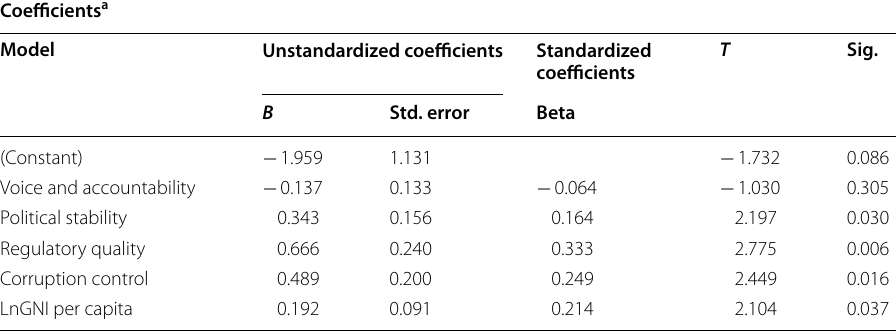
a Dependent variable: